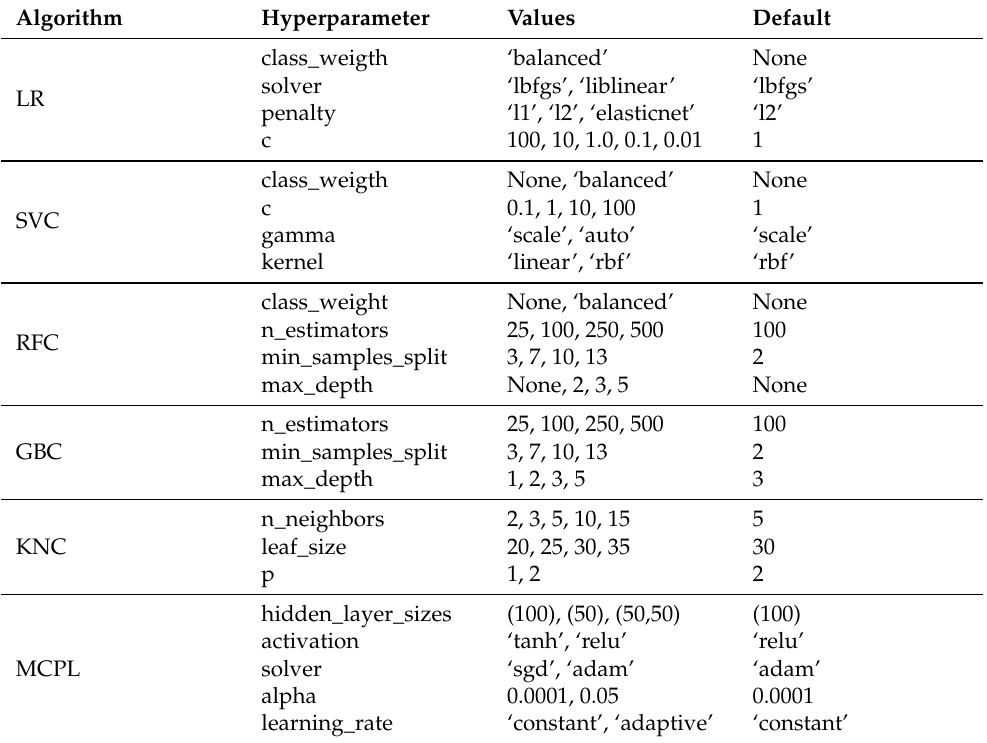
Table 3. Hyperparameters tuned for particular algorithms.